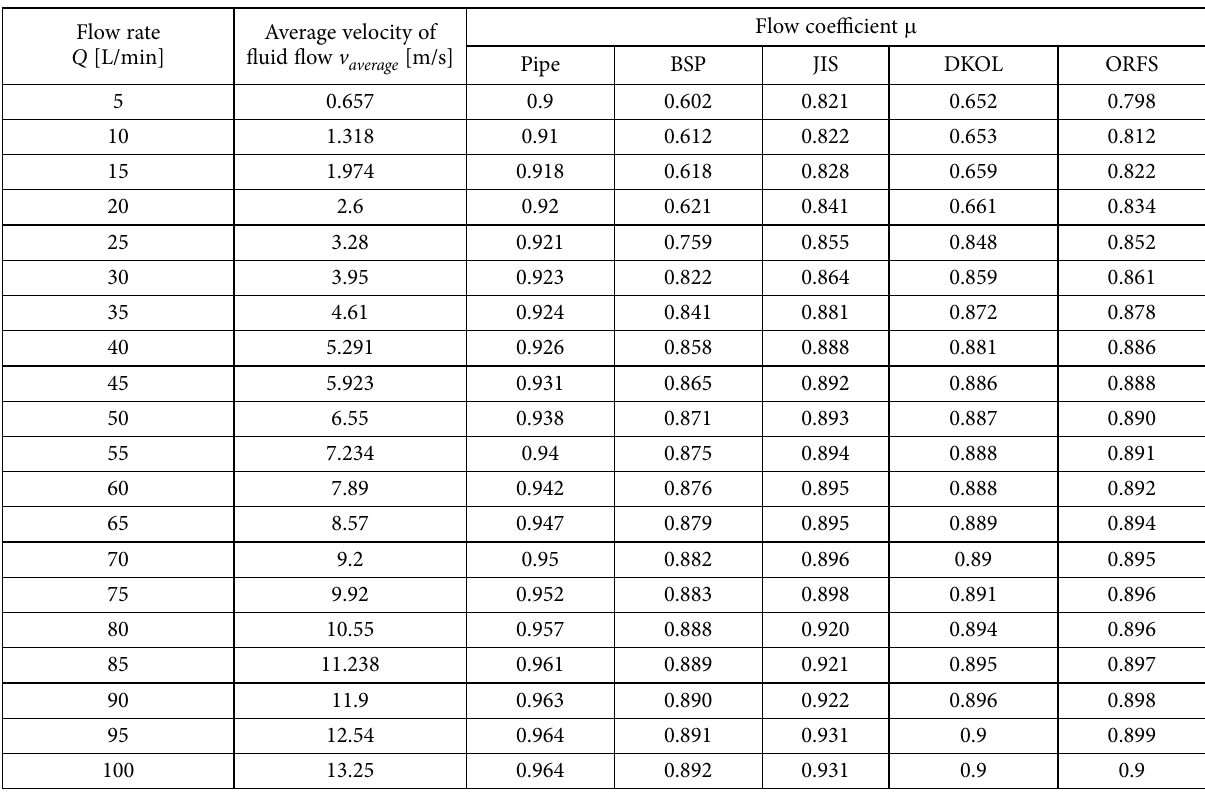
Table 8. The results of fluent simulation (flow coefficient) Flow rate Average velocity of Q [L/min] fluid flow v average